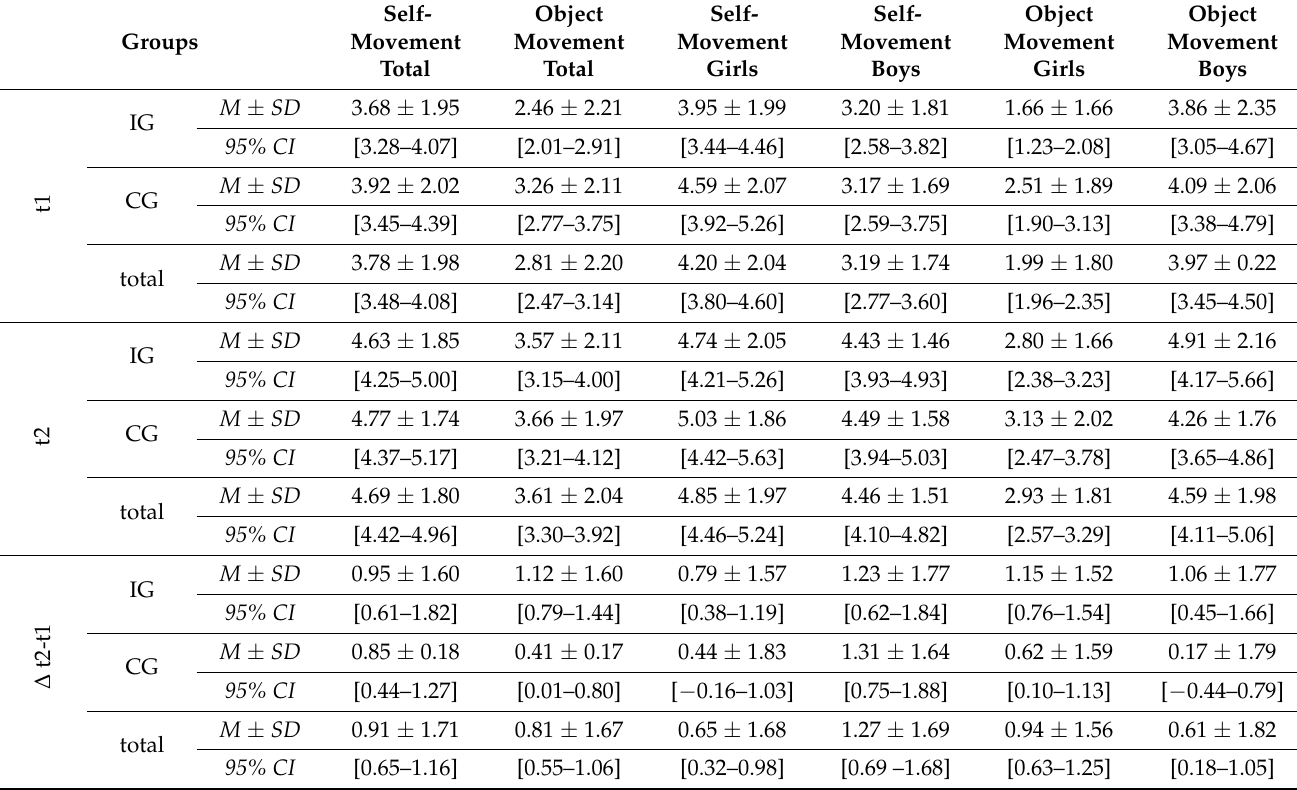
Table 3. Descriptive statistics in self-movement and object movement of IG and CG plus girls and boys.